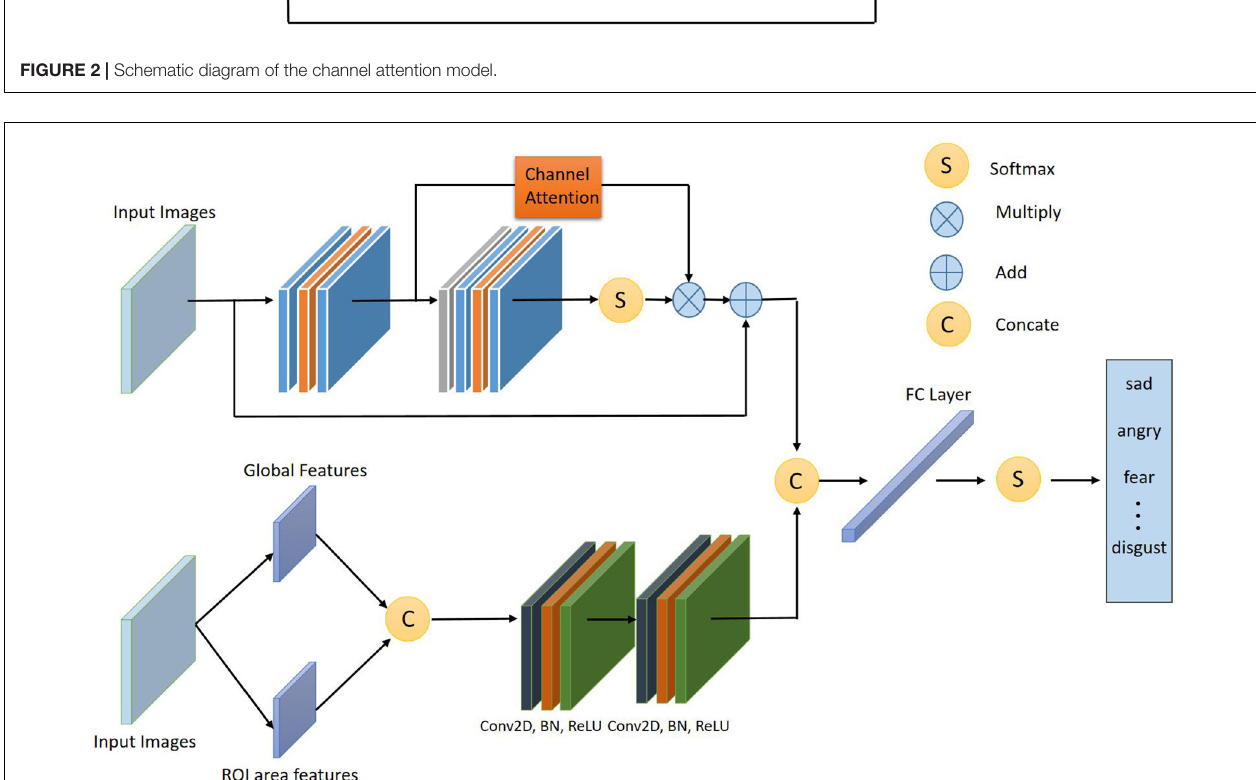
FIGURE 3 | Schematic diagram of the overall framework of the proposed